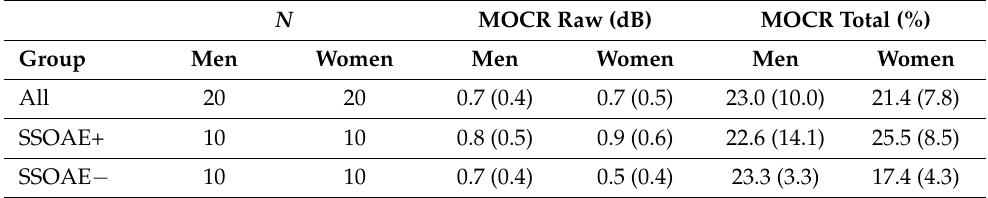
Table 2. Average MOCR shown as raw effect (in dB) and total effect (in %) (standard deviations in brackets). The data are divided according to SSOAE presence. Key: N , number of subjects/ears in each subgroup; SSOAE+, ears with SSOAEs; SSOAE − , ears without SSOAEs.